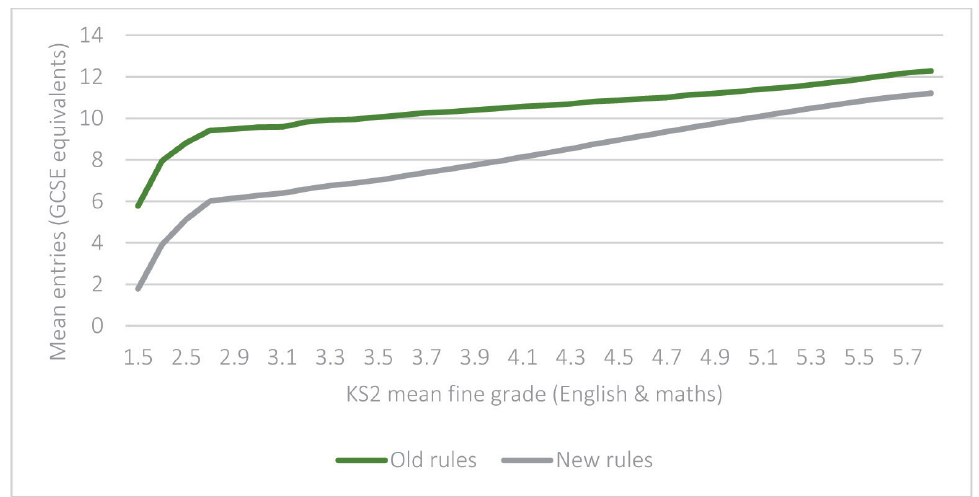
Figure 3: Mean number of GCSEs (or equivalents) entered by prior attainment, pupils reaching the end of Key Stage 4 in maintained mainstream schools